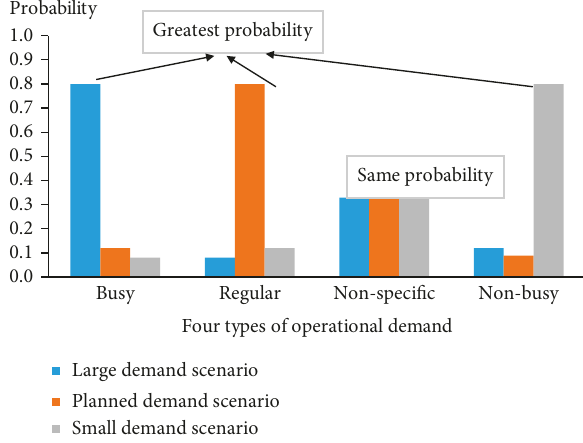
Figure 1: Schematic representation of the probability distributions for the four types of operational